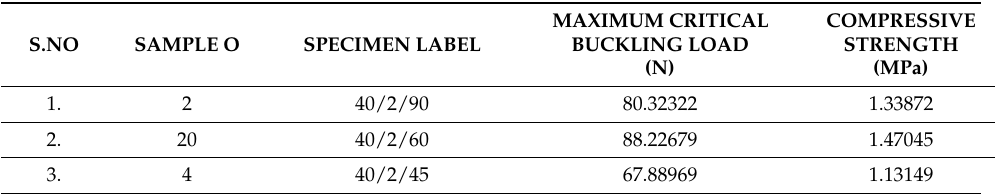
Table 6. Experimental critical buckling